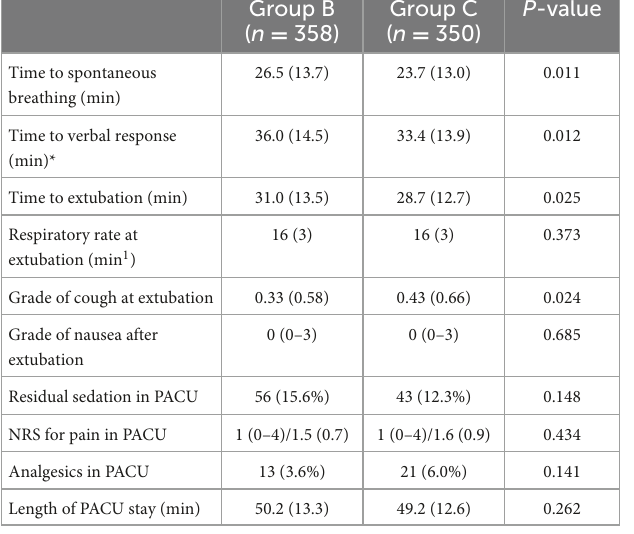
P = 0.030) ( Table 3 ). No patients experienced respiratory